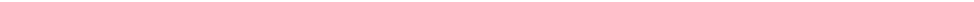
(see fi gure on previous page) Fig. 5 Rho-GTPases mediate HELLS-downstream effects. A qRT-PCR analysis of RhoA, RhoU and Pak2 expression after single or combined siRNAs in TLBR-2 and MAC2A cell lines (36 h post-nucleofection). Each data represent mean ± SEM ( n = 3). Two-tailed t -test. * p < 0.05, ** p < 0.01. B Western blots show knockdown of RhoA, RhoU, or Pak2 36 h post-nucleofection with speci fi c siRNAs in TLBR-2 and MAC2A. GAPDH was used as housekeeping gene. C The histograms show the percentage of multi-nucleated cells in at least 500 cells TLBR-2 and MAC2A stained with DAPI, F- actin, and β -tubulin antibodies (48 h post-nucleofection). Cells were nucleofected with single and combined speci fi c siRNAs against RhoA, RhoU, and Pak2. Each data point represents the mean ± SEM ( n = 3). Two-tailed t -test. * p < 0.05 and ** p < 0.01 relative to siRNA scramble. # p < 0.05 relative to RhoA KD , RhoU KD, or Pak2 KD . D The histograms show the percentage of cytokinetic cells in at least 500 cells TLBR-2 and MAC2A stained with DAPI, F- actin, and β -tubulin antibodies (48 h post-nucleofection). The term “ abnormal ” refers to cytokinetic cells with defects in cleavage furrow and/or microtubules structures. Cells were nucleofected with single and combined speci fi c siRNAs against RhoA and RhoU. Each data point represents the mean ± SEM ( n = 3). Two-tailed t -test. * p < 0.05 and ** p < 0.01 relative to siRNA scramble. E Immuno fl uorescence of TLBR-2 and MAC2A nucleofected with siRNA scramble and single and combined RhoA and RhoU siRNAs (48 h post-nucleofection). Cells were stained with DAPI, F-actin, and β -tubulin antibodies. The scale bar represents 10 μ m. F Relative growth curve of TLBR-2 and MAC2A nucleofected with siRNA scramble and single or combined RhoA and RhoU and Pak2 siRNAs (72 h post-nucleofection). Each data were normalized to siRNA scramble and represent the mean ± SEM ( n = 3). Two-tailed t -test. * p < 0.05 and ** p < 0.01 relative to siiRNA scramble. # p < 0.05 relative to RhoA KD , RhoU KD , or Pak2 KD .